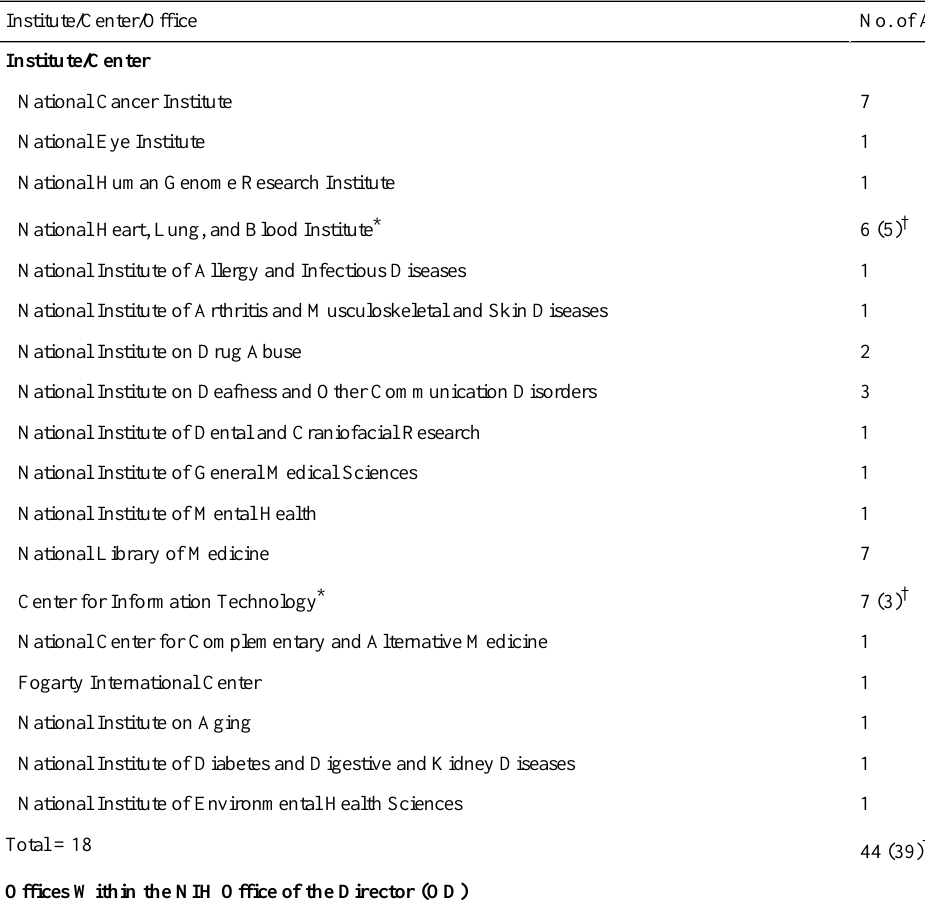
Table 1. NIH organizations participating in the trans-NIH ACSI project (See Multimedia Appendix 1 [Appendix A] for a list of the specific websites participating in the